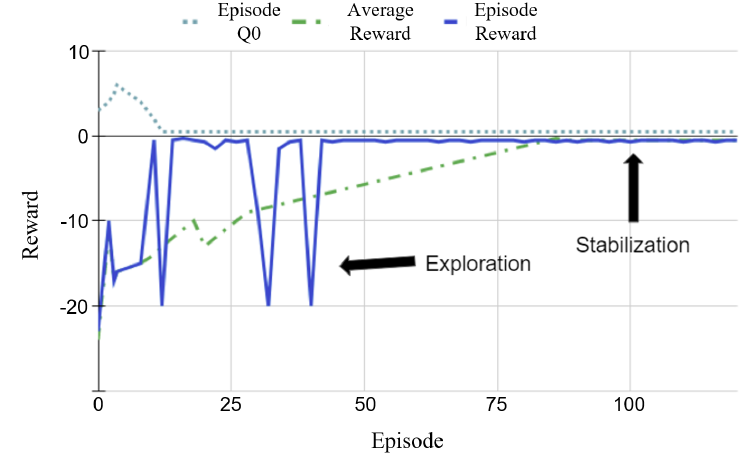
Figure 5. This typical learning curve shows the x and y axis, which are the number of episodes and the rewards, respectively. The blue line indicates the episode reward for each episode. The red line reflects the average reward (a running average reward value), while the yellow line represents the episode Q0 (the reward computed as the beginning of each episode). See Table 2 for the parameter details.